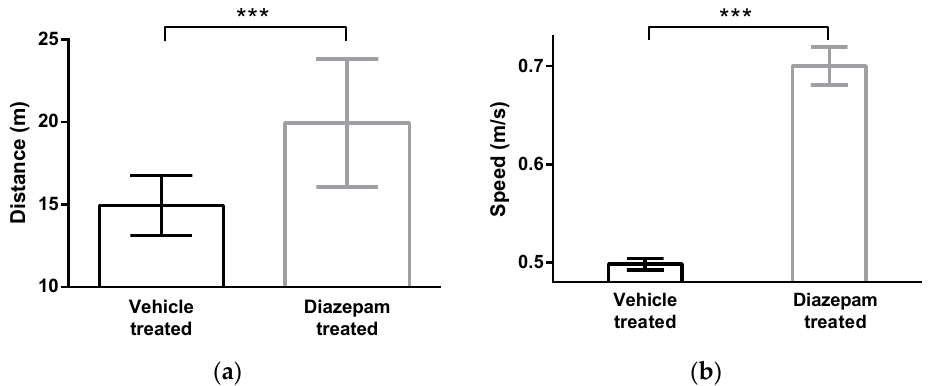
Figure A2. ( a ) Distance travelled and ( b ) average speed of traveling during 5 min EPM test, presented for C57BL/6J mice, separated for drug treatment (diazepam- and vehicle-treated mice). Error bars represent standard deviation, *** p < 0.001.